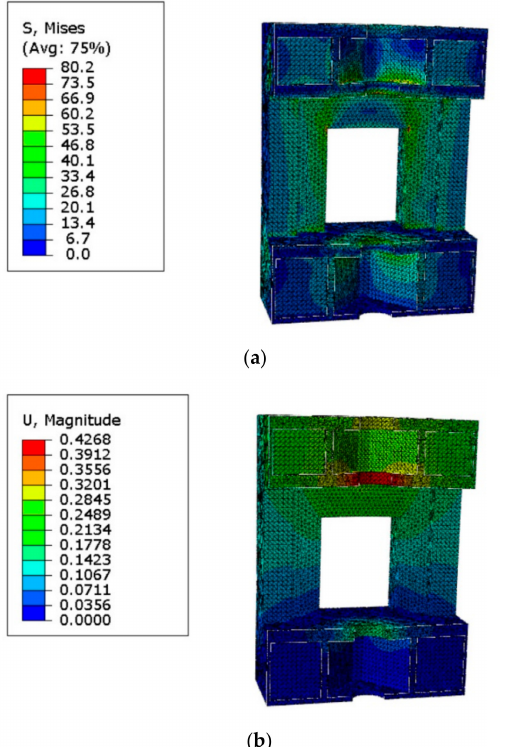
Figure 21. Static equivalent stress ( a ) and static displacement ( b ) of the optimized COF machine.